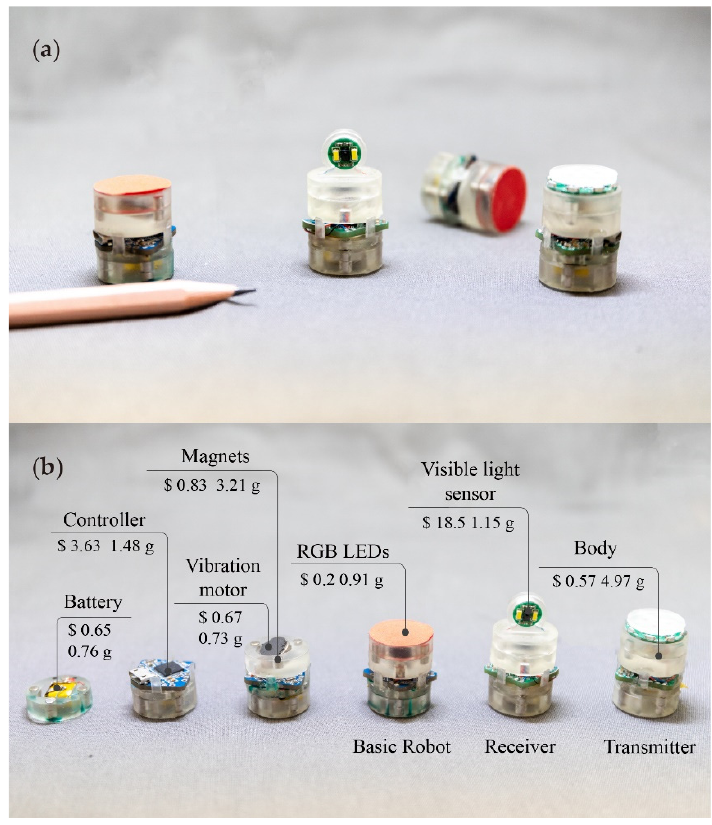
Figure 1. Miniature mobile robots. ( a ) The prototype compared with a pencil as a reference. ( b ) The components of the robot, including some RGB LEDs, a visible light sensor, the robot’s body, a vibration motor, a battery, a controller, and magnets.